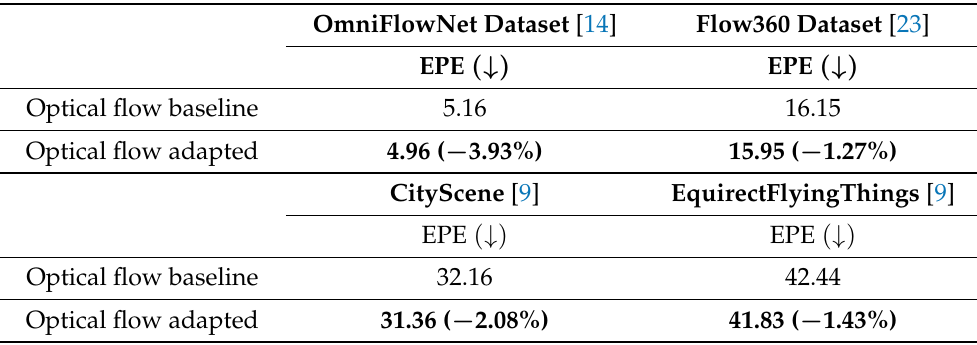
Table A3. Comparison of adapted and baseline optical flow networks on OmniFlowNet, Flow360, CityScene, and EquirectFlyingThings